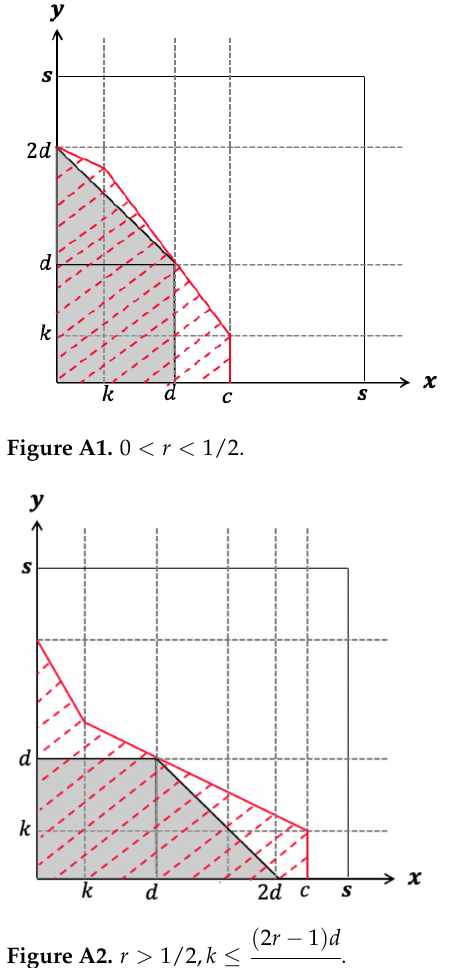
Figure A2. r > 1/2, k ≤